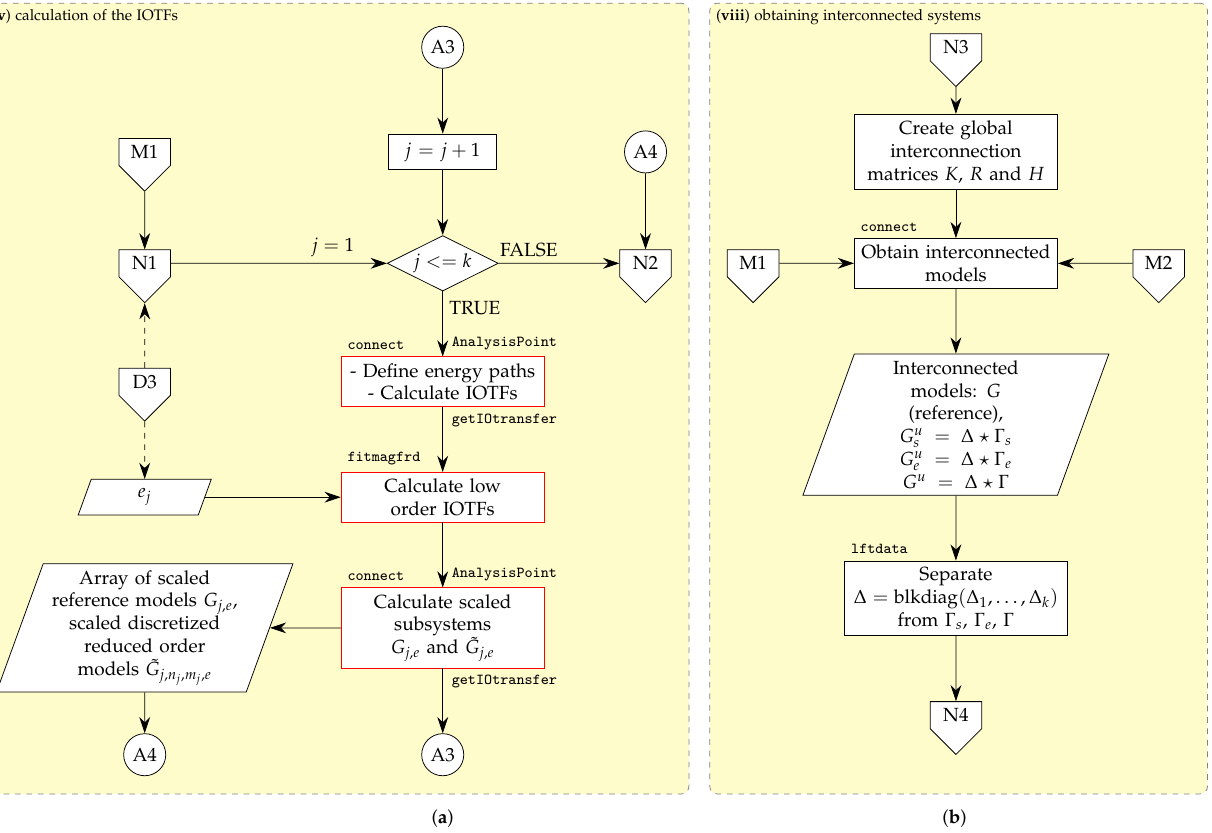
Figure 4. Structure of the system is used to obtain the insight into how energy is being dissipated (damped) inside the system. Interconnection matrices are used to create interconnected reference system and interconnected uncertain systems ( a ) complex interconnections (or surroundings, envi- ronment) around each subsystem are essentially acting as scaling filters at input and output of each subsystem (input output transfer functions-IOTFs). These scaling filters (IOTFs) are reduced and used to calculate a low order scaled versions of both the reference model and discretized reduced order model. ( b ) Once the interconnection matrices R , K and H have been created, and a reference interconnected system is obtained (i.e., G )-uncertain interconnected system(s) can also be obtained using the same interconnection matrices and replacing the appropriate reference subsystems with the relevant uncertain subsystems (i.e., replace G j with G u , G u or Gj u j , s j , e